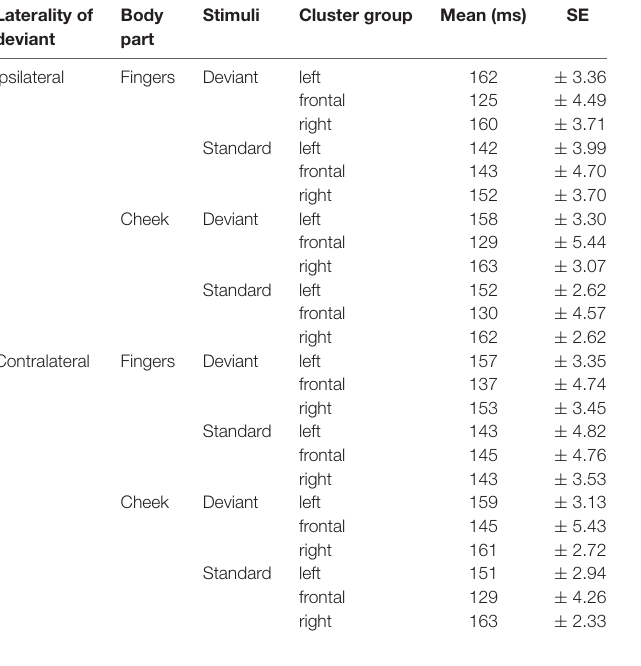
TABLE 3 | Mean latencies of N140 with SE values.